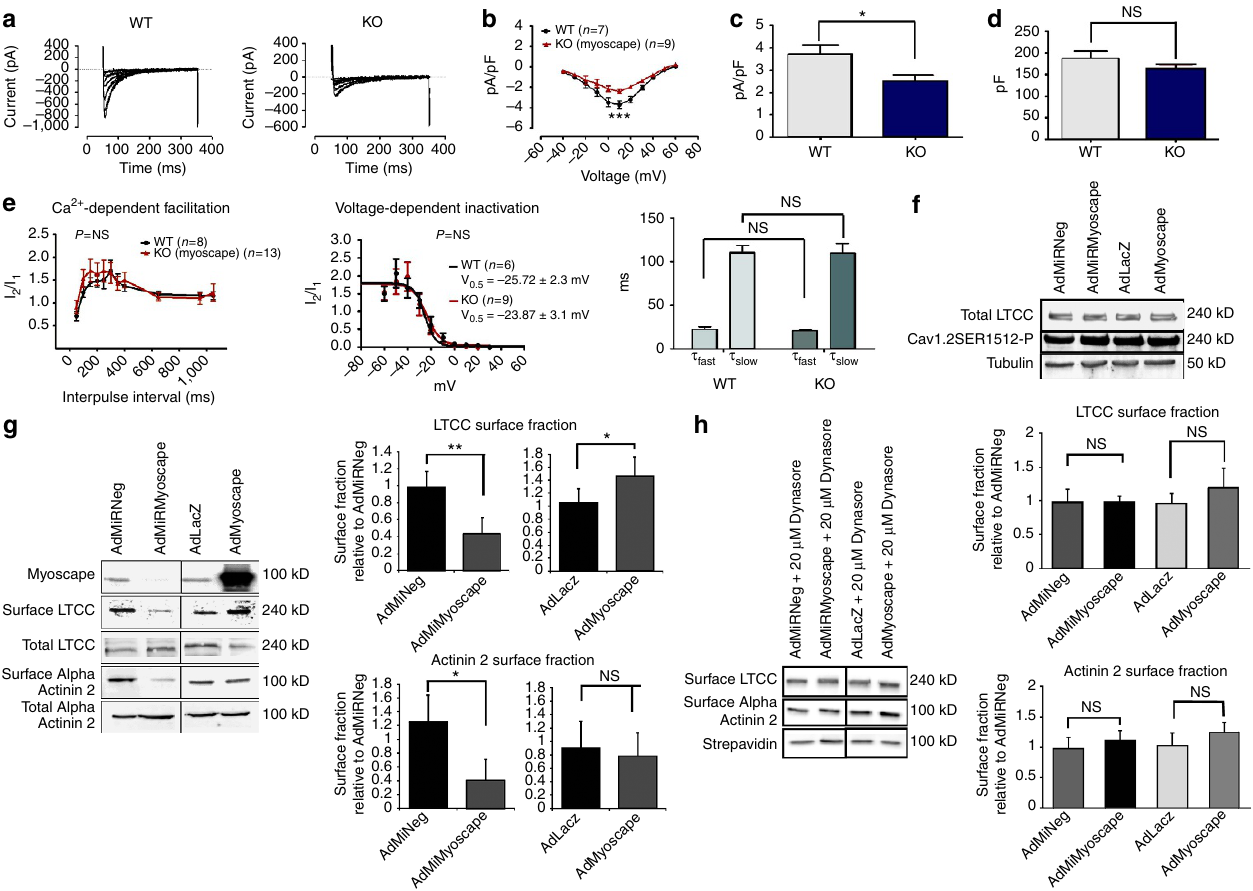
Figure 5 | Myoscape regulates LTCC surface retention. ( a ) Electrophysiological measurements of ventricular cells from Myoscape KO and WT mice showing impaired LTCC currents. Cells were stimulated by the voltage protocol. A prepulse of (cid:2) 80 to (cid:2) 40mV was used to inactivate fast Na þ currents. Current traces and voltage protocols are superimposed from (cid:2) 40 to þ 60mV. Current–voltage relation of ICa Peak current density was plotted